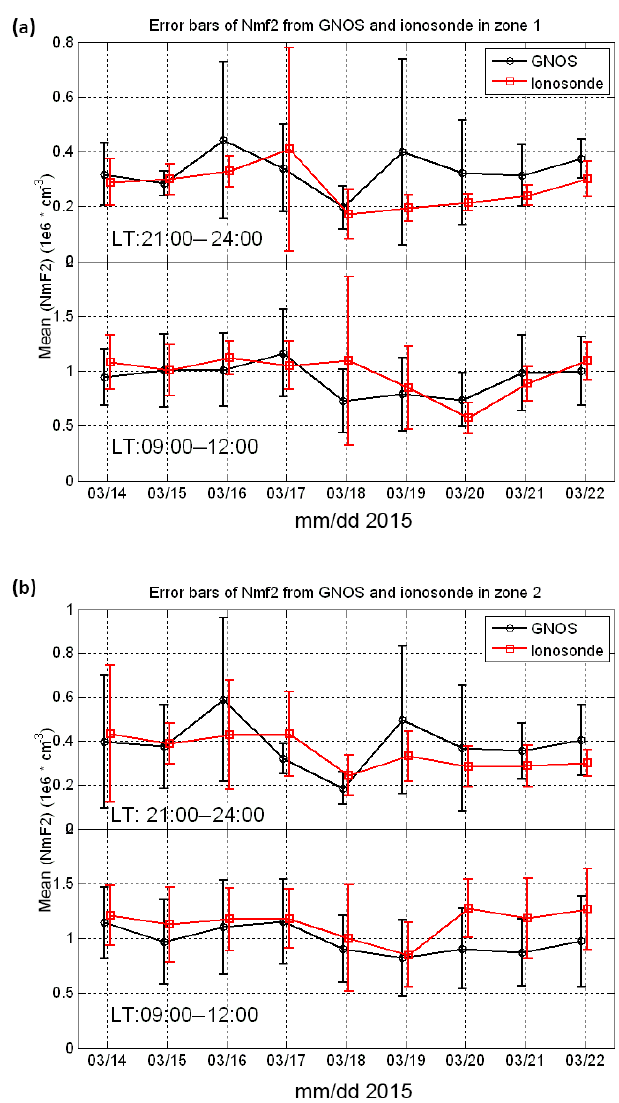
Figure 11. (a) Comparison of error bars of NmF2 values from the eight ionosonde stations and GNOS in zone 1 in the Northern Hemi- sphere during the magnetic storm of March 2015. (b) Same as (a) , but for the comparison of error bars of NmF2 values from the seven ionosonde stations and GNOS in zone